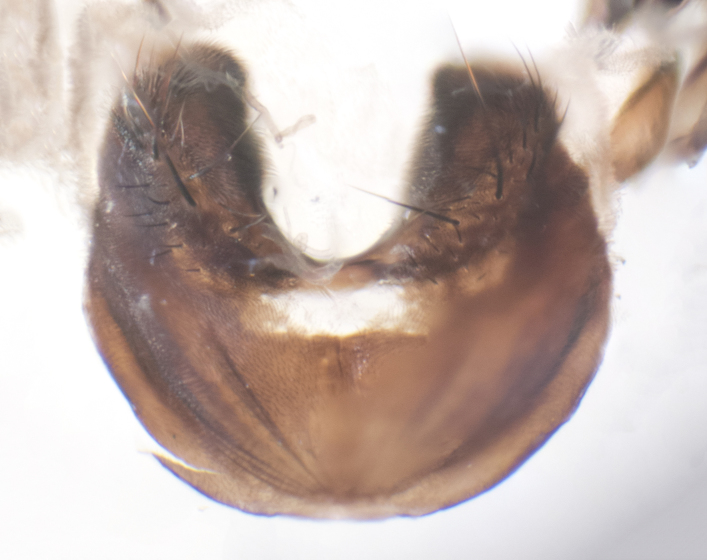
sternite 5, ventral view